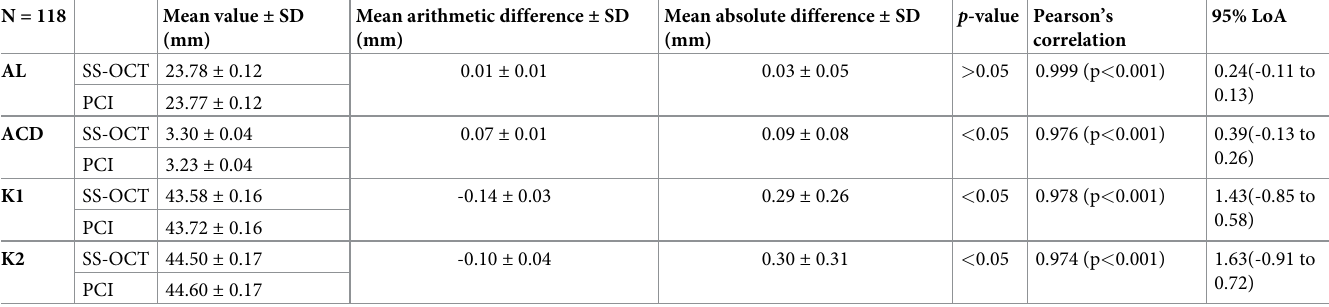
Table 2. Biometric data measured by PCI and SS-OCT